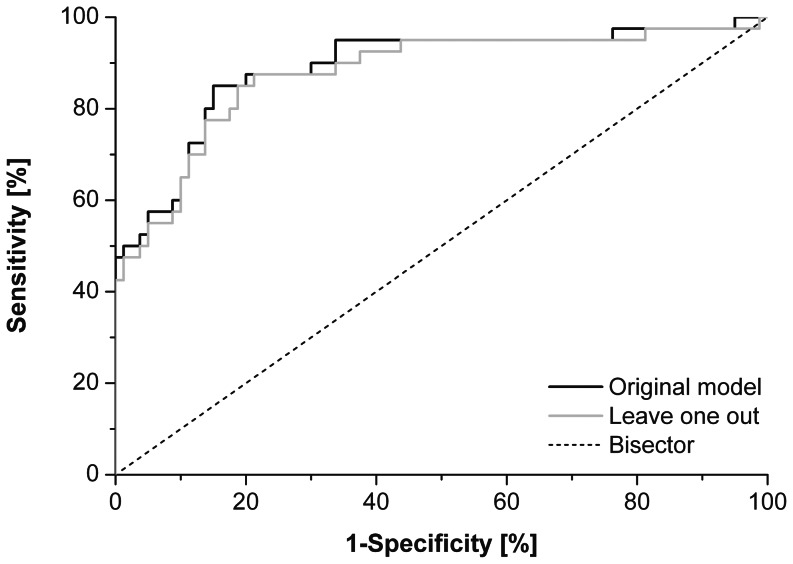
ROC analysis.The ability of the model of discriminating patients with MS from the HC group is demonstrated by the area under the ROC curve (AUC = 0.89 (95%CI = 0.820.96, p<0.001)), even when evaluated using a cross-validation procedure based on the leave-one-out method (AUC = 0.88 (95%CI = 0.81–0.95, p<0.001)).